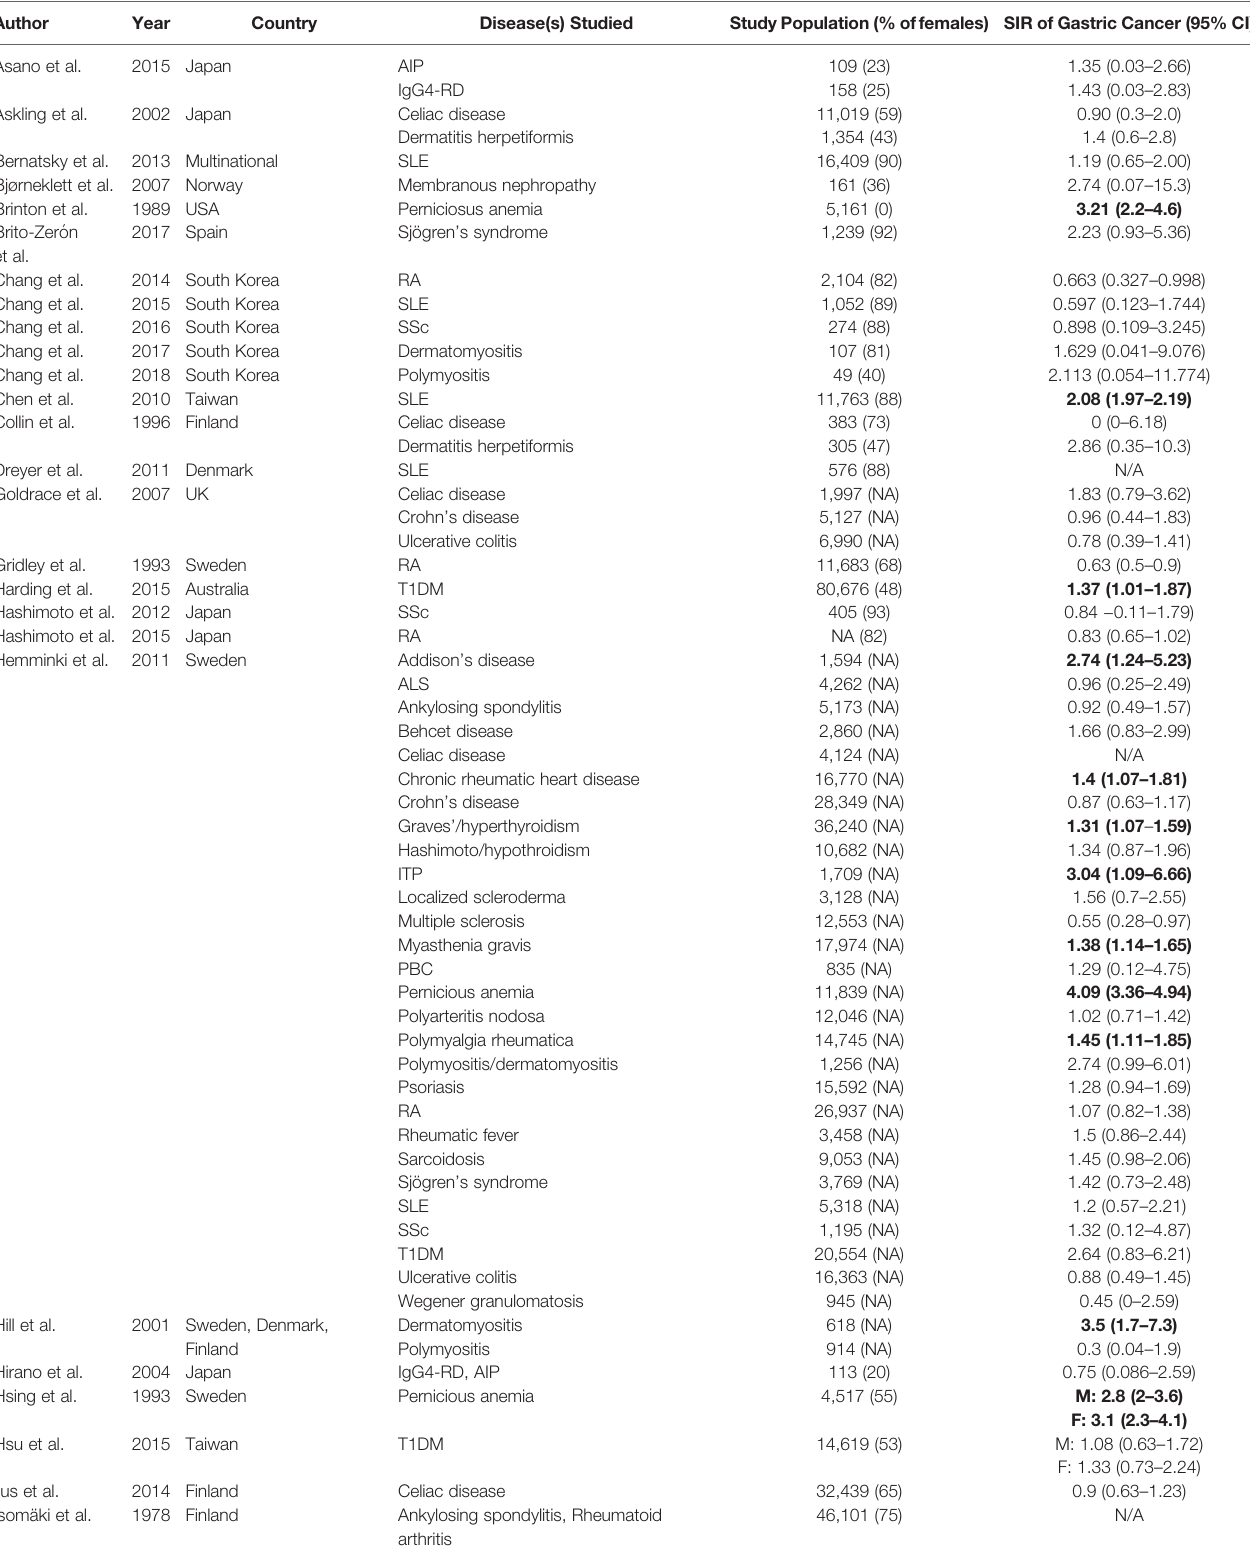
TABLE 1 | Basic characteristics of included